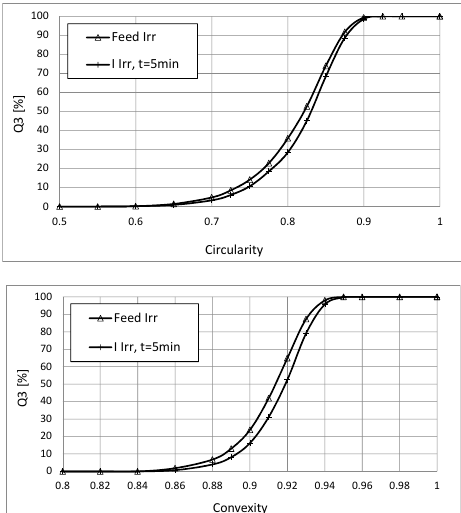
Figure 13. Particle size distribution curves for feed and enrichment products with regular and irregular particles. Minerals 2020 , 10 , x FOR PEER REVIEW